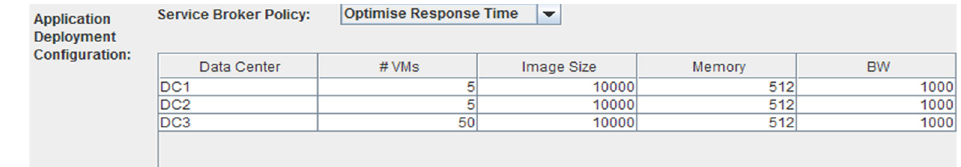
Figure 8. Application deployment configuration of Data Centers 1 to 3 based on CDC SBP.